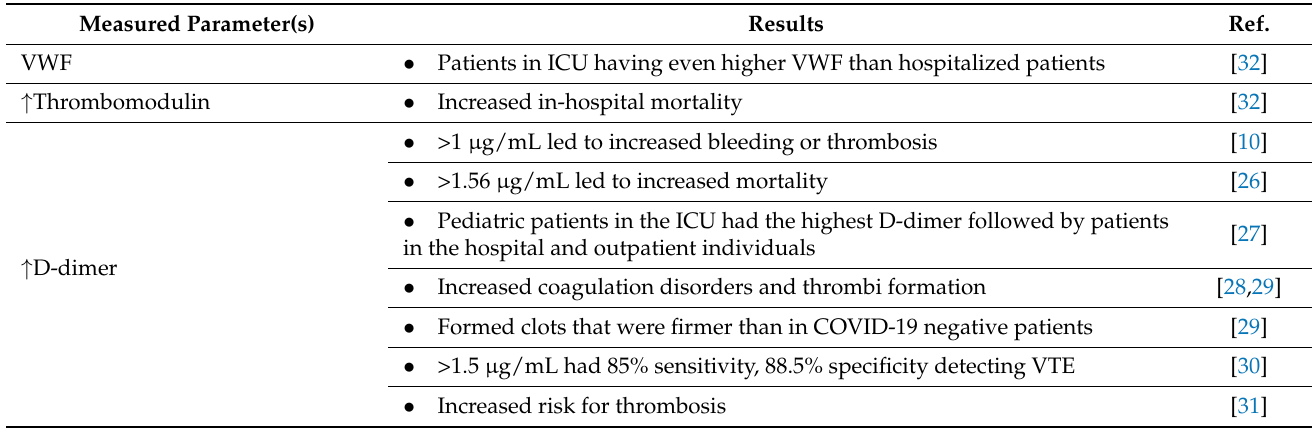
Table 3. A summary of different parameters and their combinations in COVID-19 positive patients and their outcomes, complications, and risk factors.